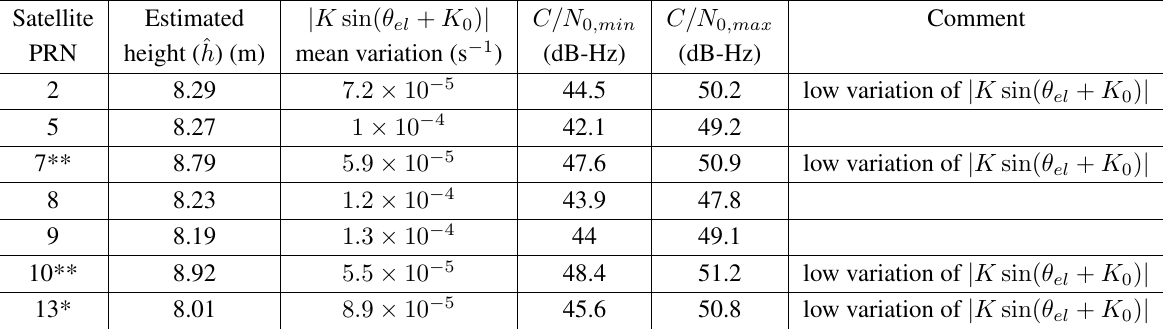
Table 5. 17 January 2014, at 14h09 UTC. Reference height: h = 8 . 24 m, ∆ x = 1 . 92 m.